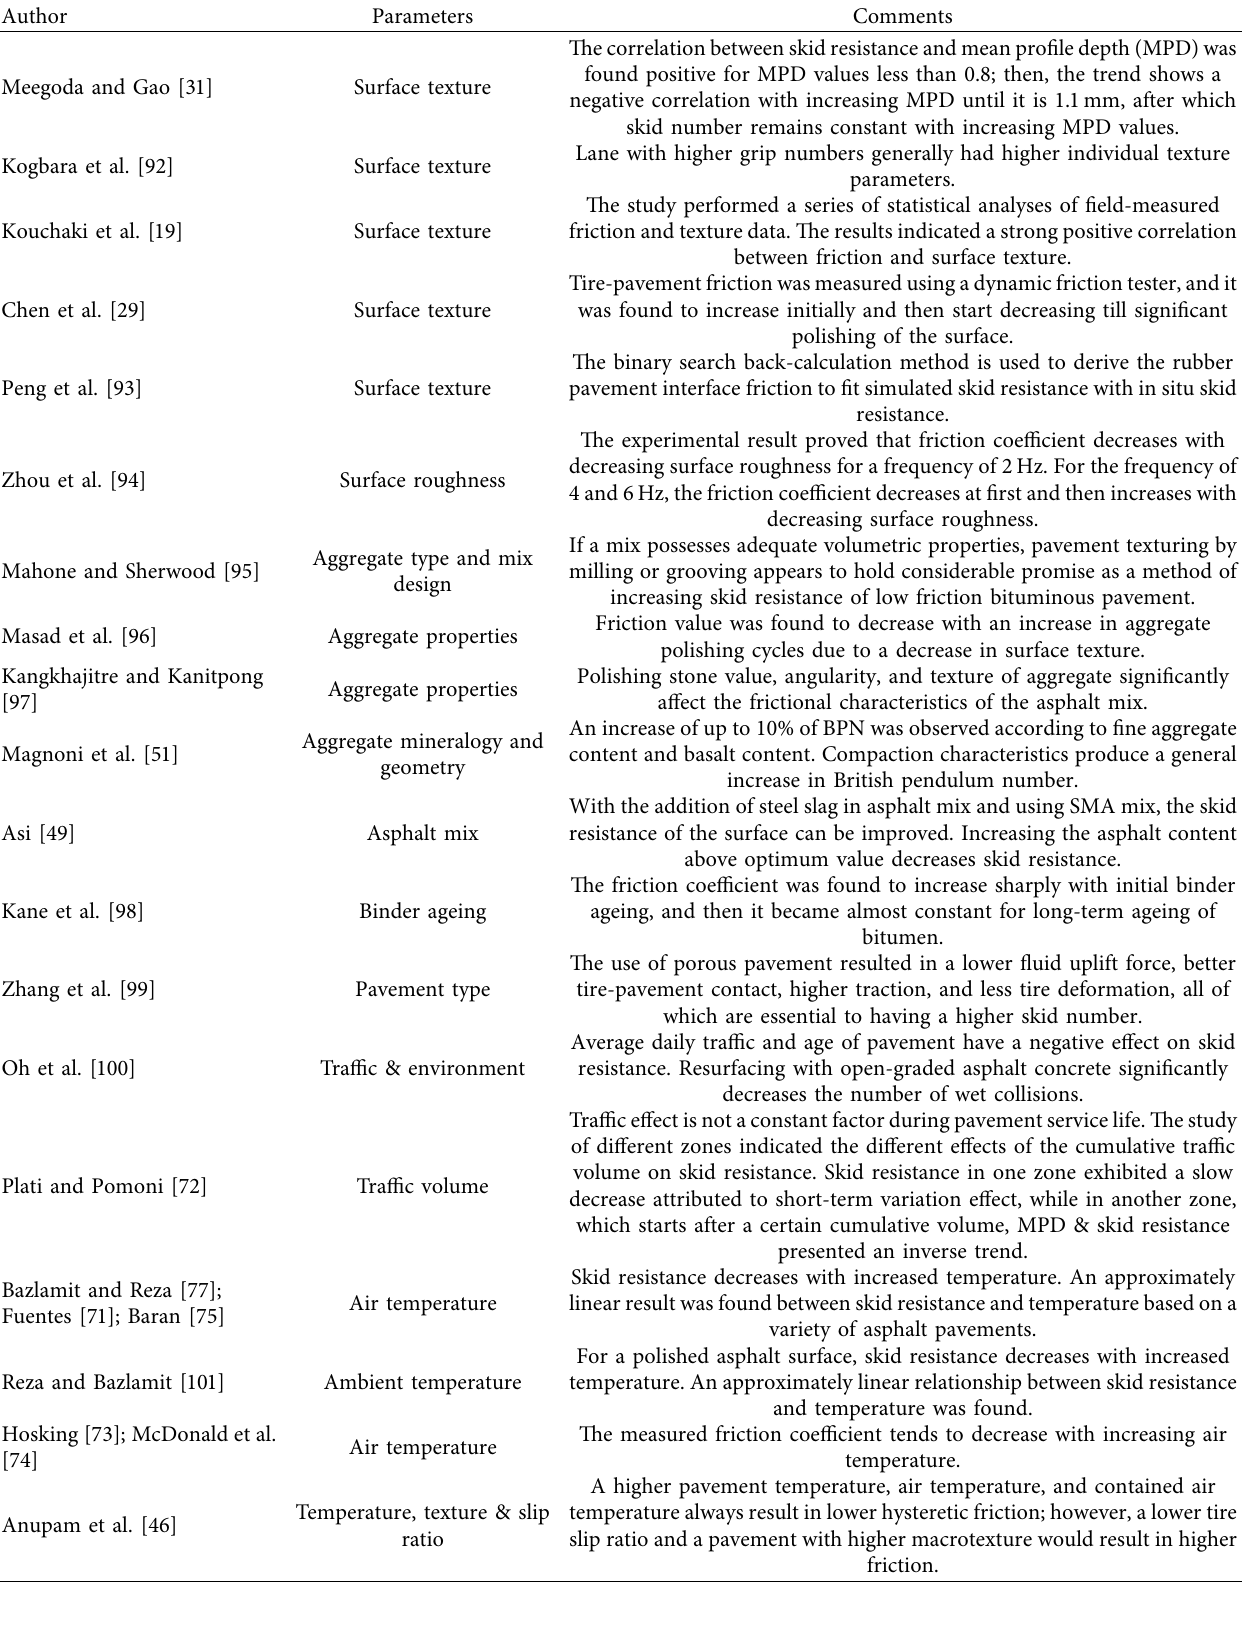
Table 5: Factors affecting skid resistance and their history in modelling frictional